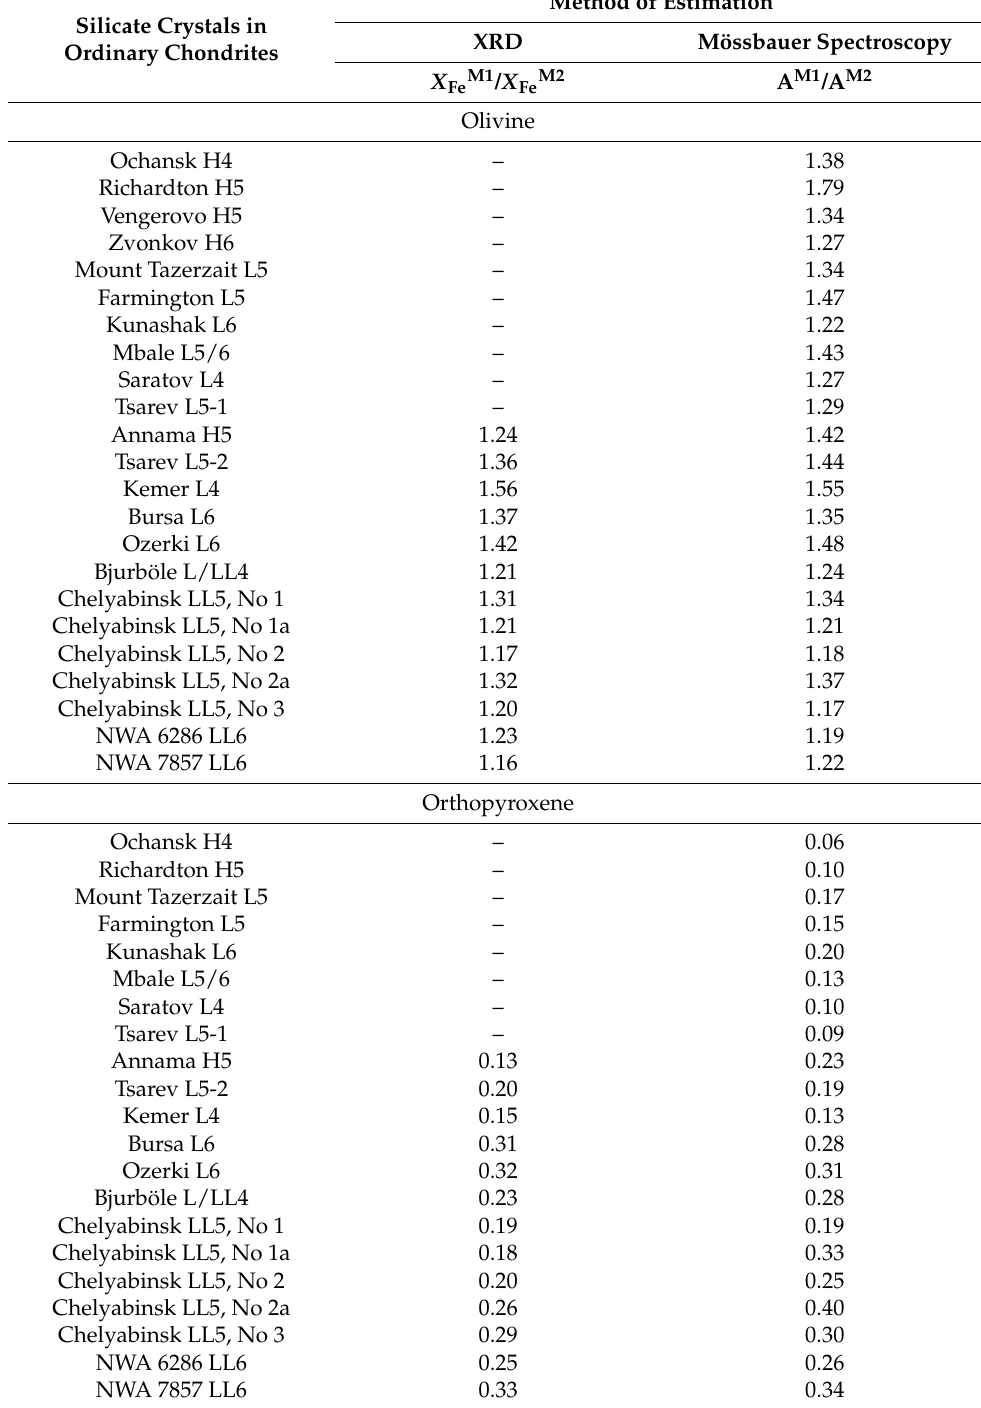
Table 1. The ratios of Fe 2+ fractions in the M1 and M2 sites in olivine, orthopyroxene and Ca- rich clinopyroxene crystals in ordinary chondrites determined by means of X-ray diffraction and Mössbauer spectroscopy (data were taken from References [100,101,107,112]). Method of Estimation Silicate Crystals in XRD Mössbauer Spectroscopy Ordinary Chondrites X FeM1 / X FeM2 A M1 /A M2